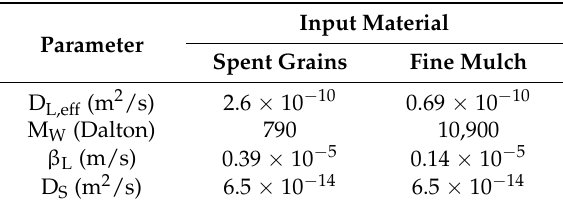
Table 4. Effective bulk diffusivities D L,eff , mean molecular weights M W , mean film mass transfer coefficients β L for a filter velocity of 0.6 m/h that were needed to model the column test data, and mean intra-particle diffusivities D S for biologically pre-treated HTC process